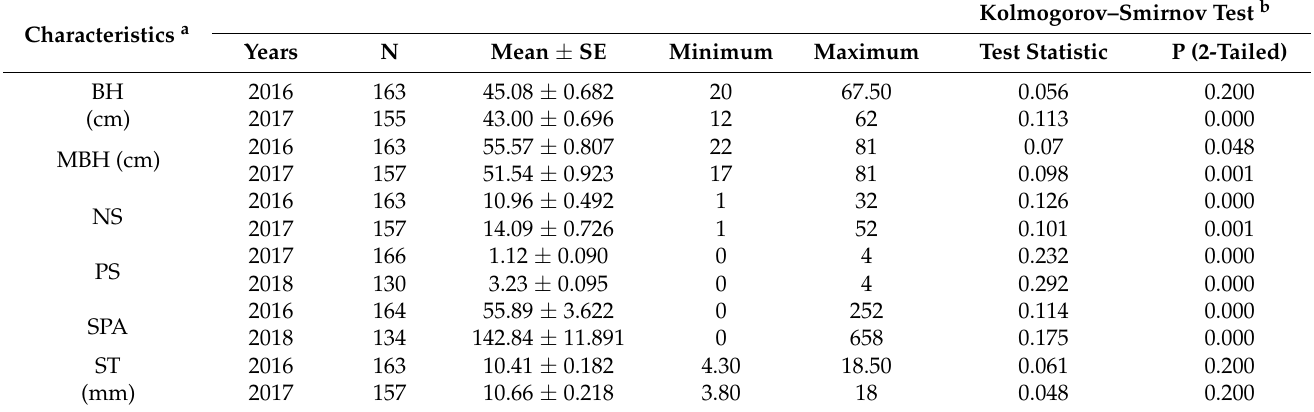
Table 1. Descriptive statistics and normality analysis of morpho-agronomic traits in a F 1 population of garden asparagus.